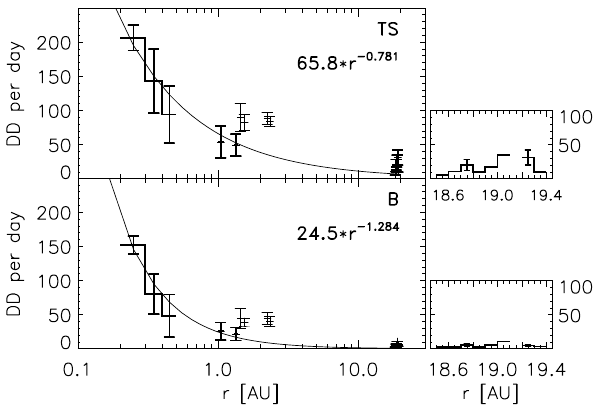
Fig. 5. Distribution of DD ? per day normalized on 400km/s over r with a bin size of 0.1 AU; analog to Fig. 3.